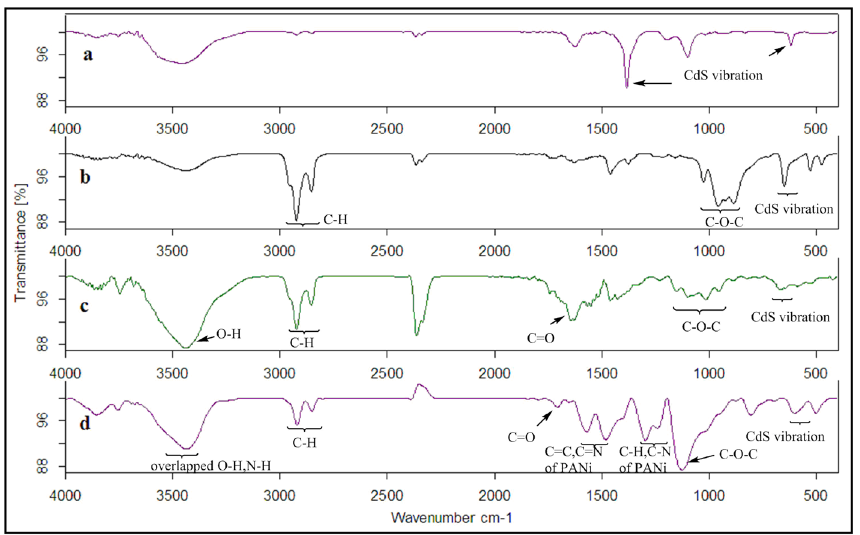
Figure 3. The IR spectra of ( a ) CdS NPs, ( b ) mCdS NPs, ( c ) mCdS@HPEc NPs, ( d ) mCdS@HPEc-g-PANi nanocomposite.